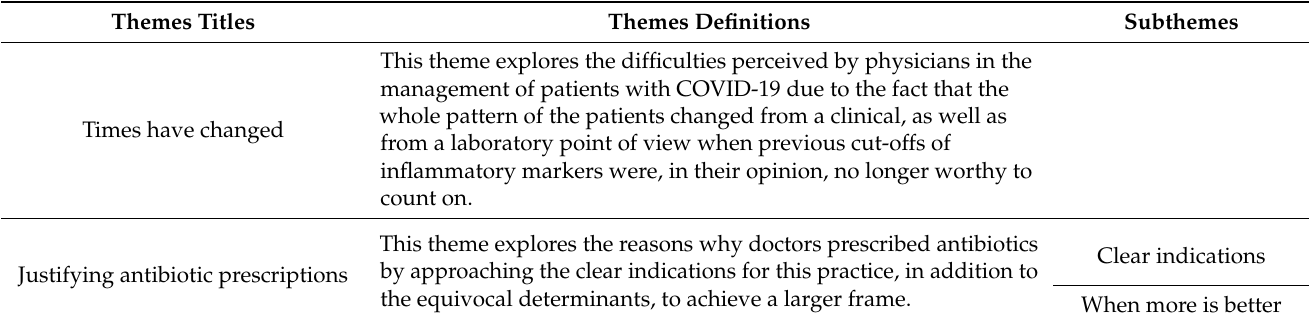
Table 5. Overview of